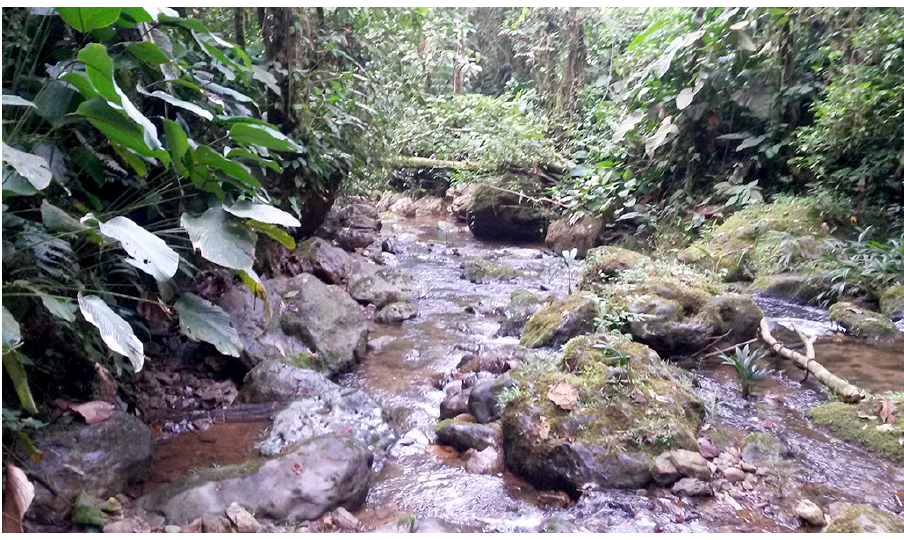
FIGURE 9 | Quebrada Sune, tributary of Pachijal River, Pichincha. Type locality of Microglanis berbixae